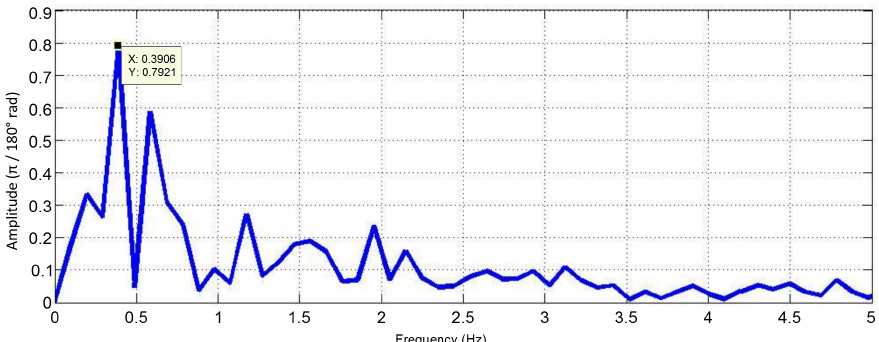
Figure 10. Amplitude spectrum of commanded elevator